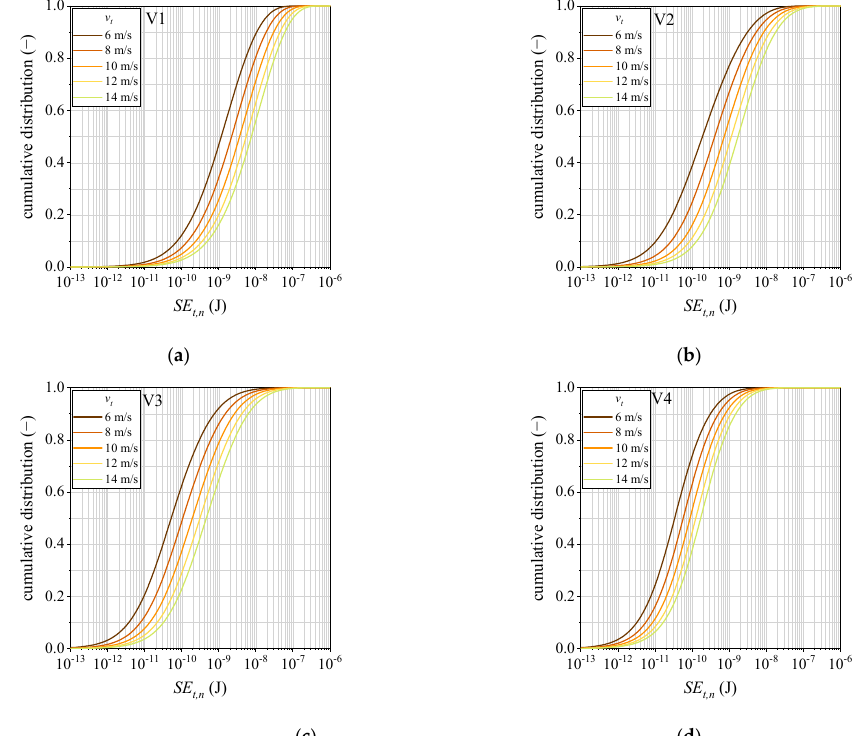
Minerals 2021 , 11 , x FOR PEER REVIEW 19 of 21 Figure A1. Stress energy distribution for the trans ‐ normal direction at varied stirrer speeds and a grinding media filling Figure A1. Stress energy distribution for the trans-normal direction at varied stirrer speeds and a grinding media filling of of 80% in ( a ) V1, ( b ) V2, ( c ) V3, and ( d ) V4. 80% in ( a ) V1, ( b ) V2, ( c ) V3, and ( d ) V4.